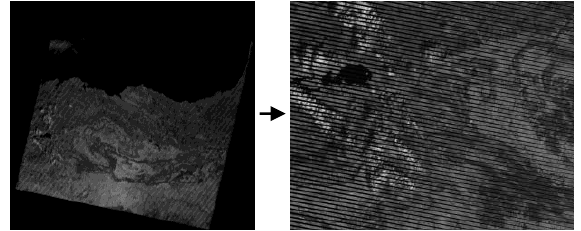
Figure 9. Example of striping error in Landsat 5 Band 4 data visible at the image borders.